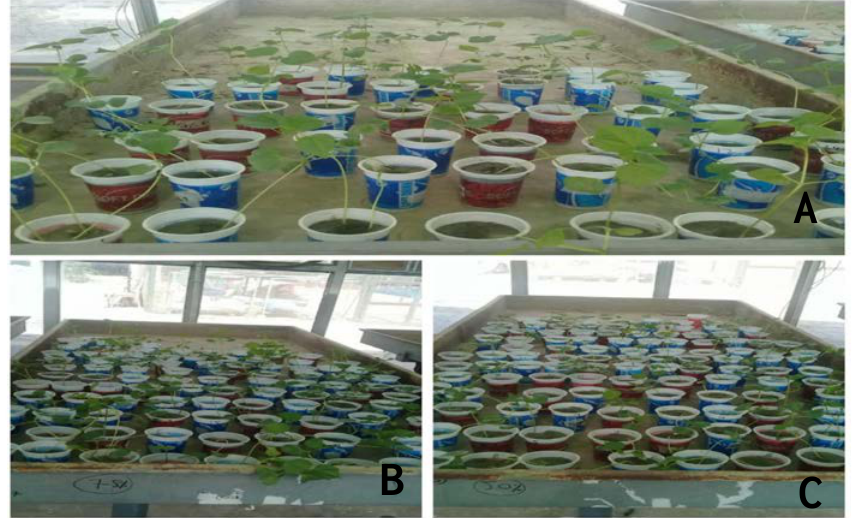
Figure 2. A visual representation of cotton plant growth under both normal and drought stressed conditions. ( A ) Treatment with 100% (FC) water irrigation served as a control; ( B ) Treatment with 75% (FC) water stress level; ( C ) Treatment with 50% (FC) water stress level. The effect of drought was monitored using soil moisture meter (HH2 Theta Probe Type, Delta-T device, Cambridge, England). Data based on morpho-physiological